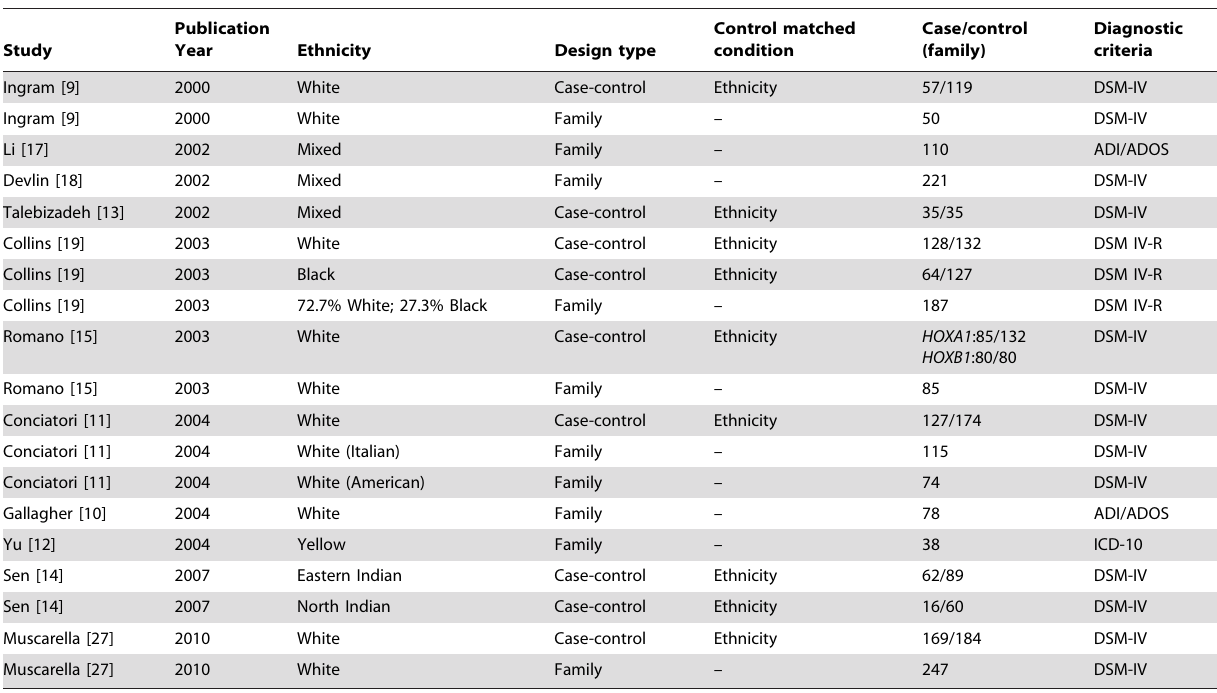
Table 1. Characteristics of included